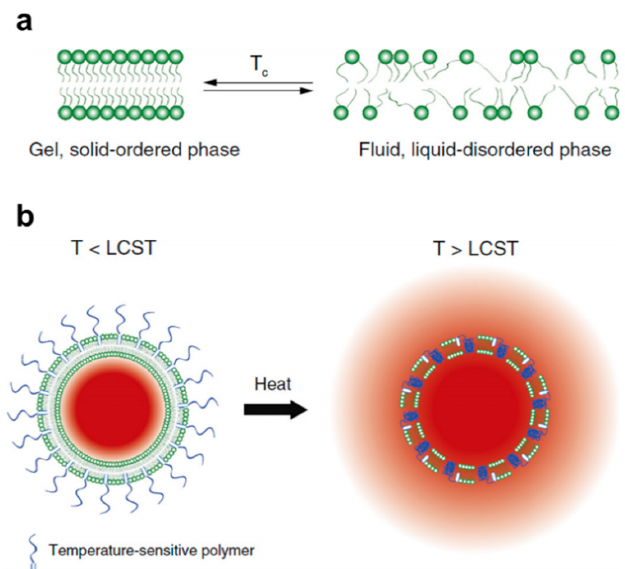
Figure 3. Schematic representation of thermoresponsive liposomes ( a ) Temperature-dependent phase transition of a lipid bilayer. An increase in temperature above Tc is associated with an increase in the lipid bilayer fluidity and an increase in drug release. ( b ) Temperature-responsive polymers disrupt the liposome membrane in response to heating with a consequent increase in drug release. Reproduced with permission from [108] . Copyright Elsevier, 2013.